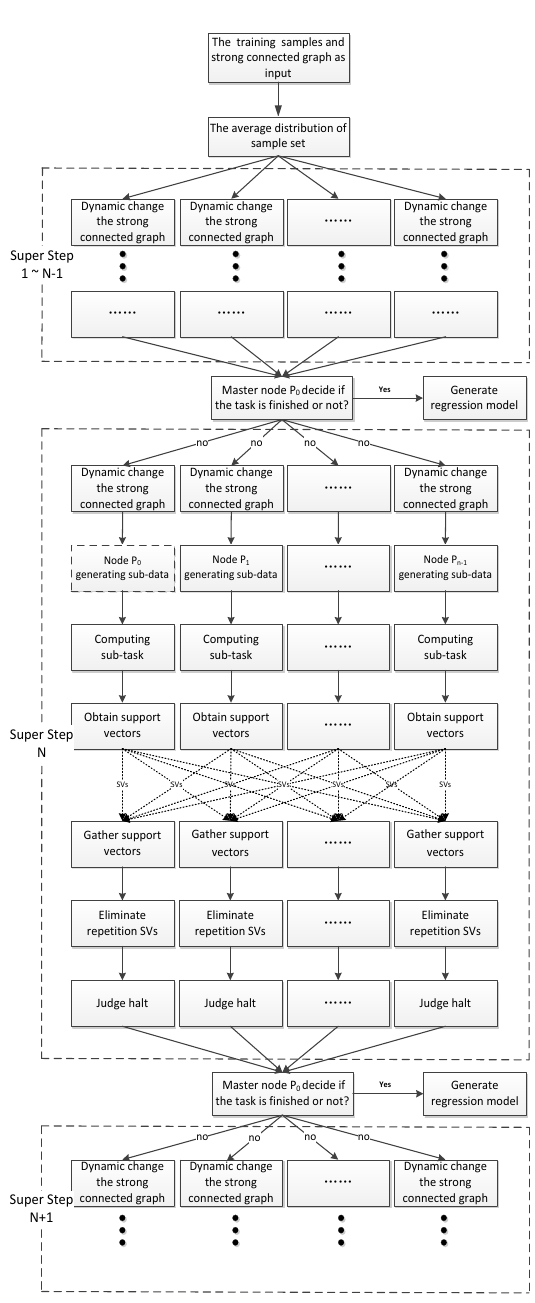
Fig. 4. BSP-Based Support Vector Regression Machine Framework.